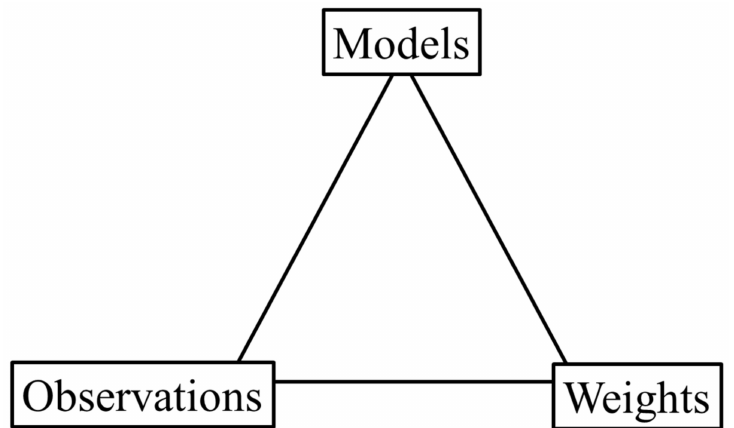
Figure 5. Representation of the components involved in the analysis of a DNA